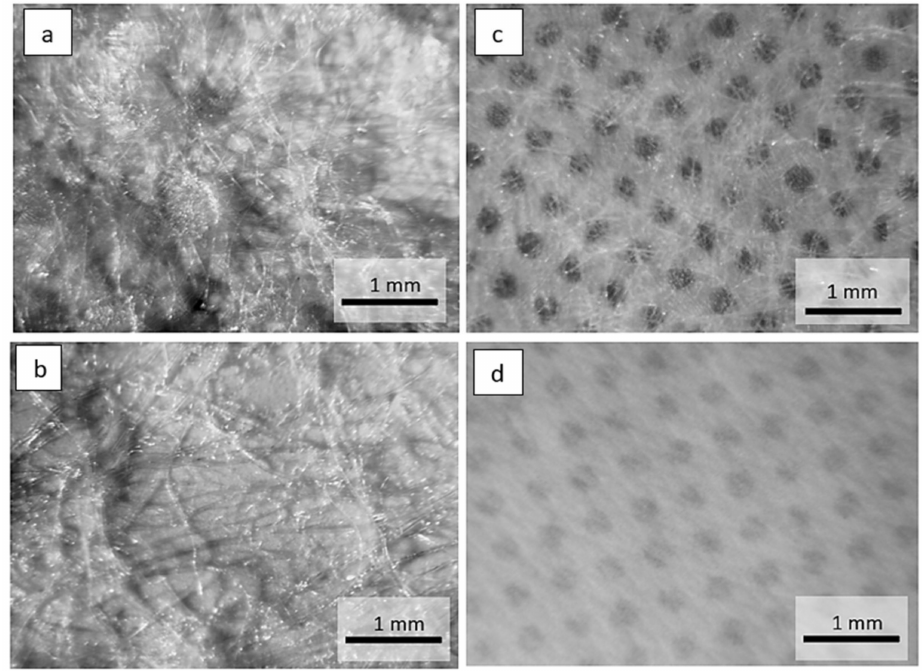
Figure 2. Optical microscope images of the materials: ( a ) non-woven side, ( b ) foil side of